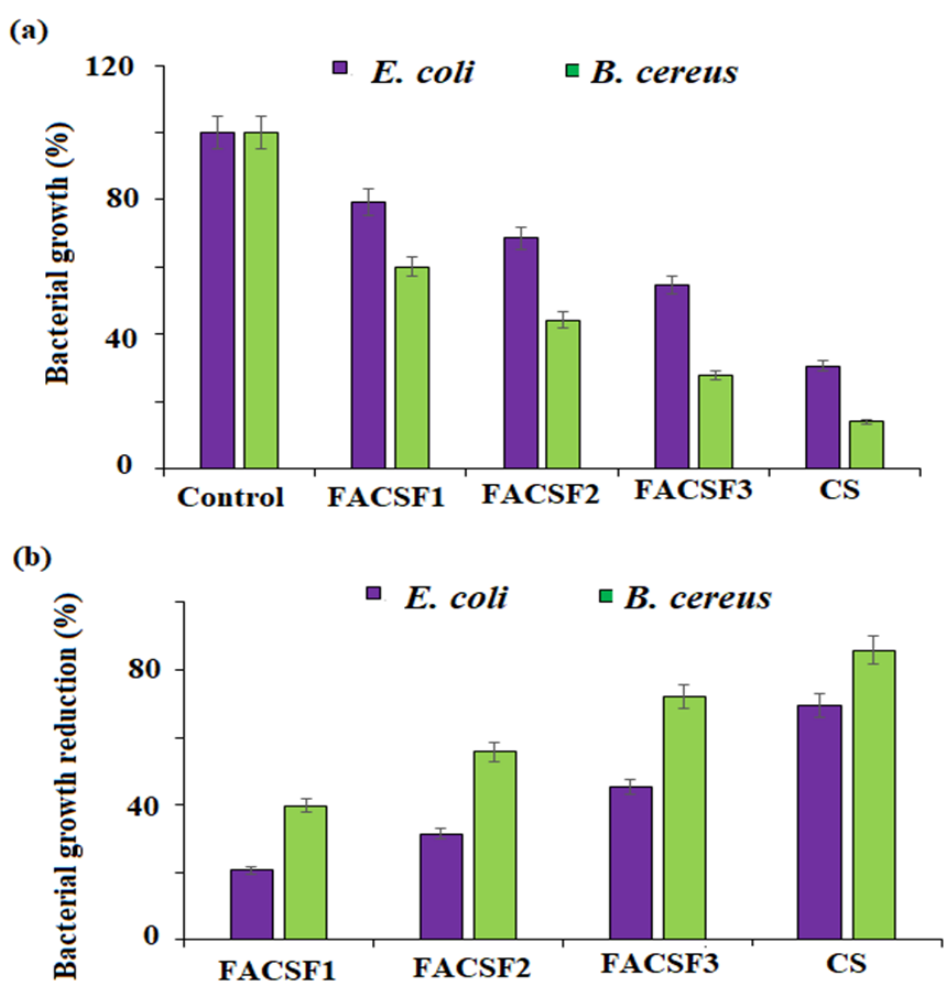
Figure 7. ( a ) Bacterial growth %, and ( b ) bacterial growth reduction % against E. coli (Gram-negative) and B. cereus (Gram-positive) microorganisms. Data were presented in average mean ± SD ( n ≥ 3).